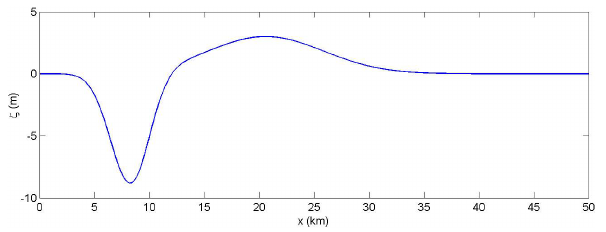
Fig. 1. The leading depression N-wave shape.